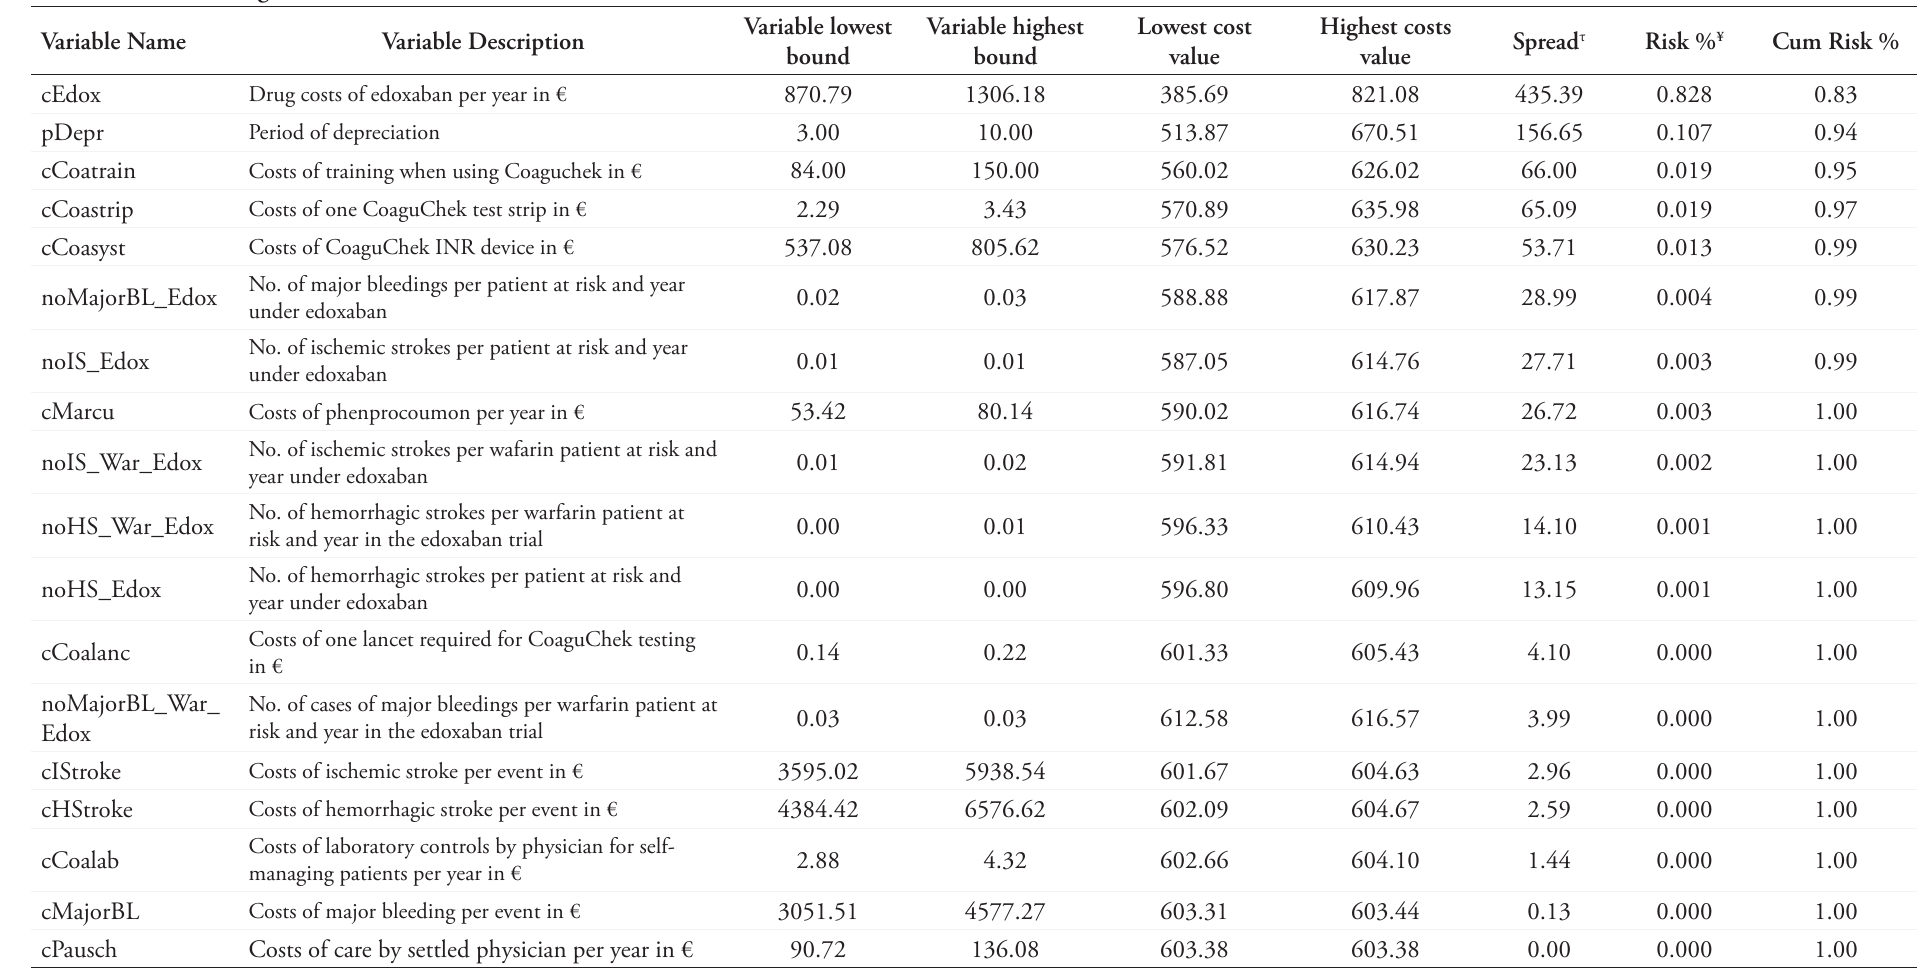
Table 5c: Tornado diagram*: VKA under PST versus